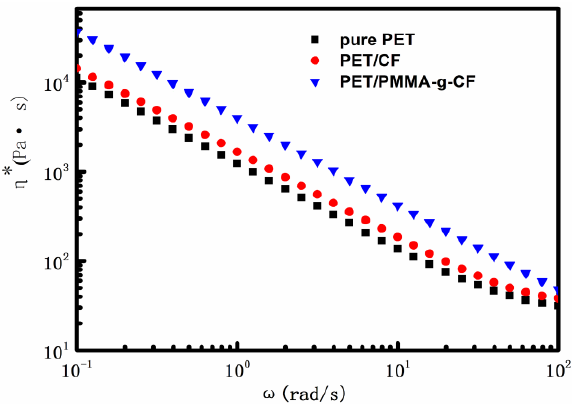
Figure 5. Complex viscosity (η*) vs. angular frequency (ω) for pure PET, PET/CF, and PET/PMMA-g-CF composites. The storage modulus (G (cid:48) ) and the loss modulus (G (cid:48)(cid:48) ) versus frequency ( ω ) for all the test samples